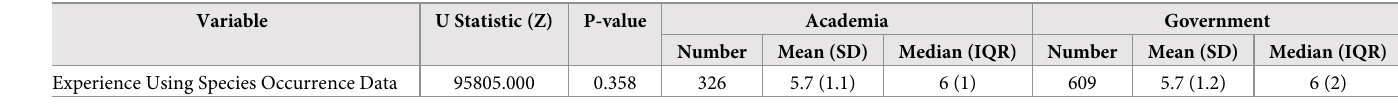
Table 5. Mann-Whitney U tests of level of experience using species occurrence data.